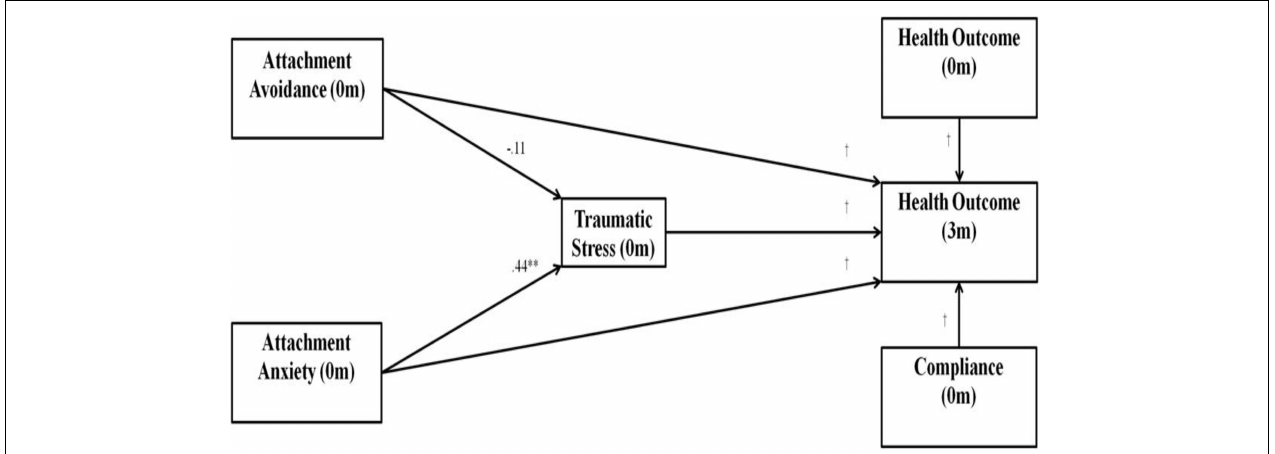
FIGURE 1 | Multivariate structural equation model used for path analysis. Hypothesized pathways included attachment anxiety and avoidance having indirect effects on health outcome variables through traumatic stress. m, months.